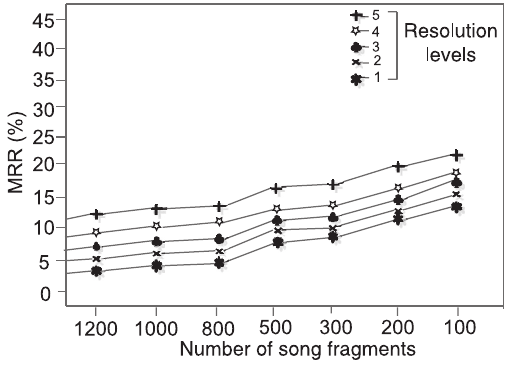
Figure 6. MRR Analysis.